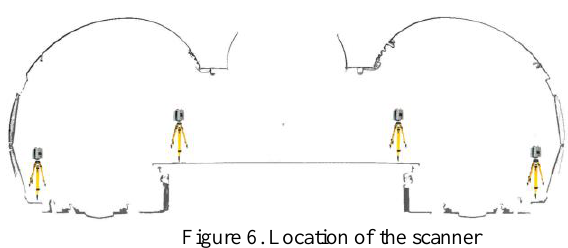
Figure 6. Location of the scanner